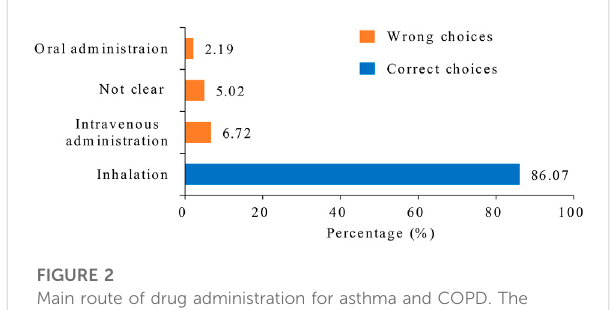
FIGURE 2 Main route of drug administration for asthma and COPD. The numbers indicate the percentage of the selection. The blue strip represents the correct choice. COPD, chronic obstructive pulmonary